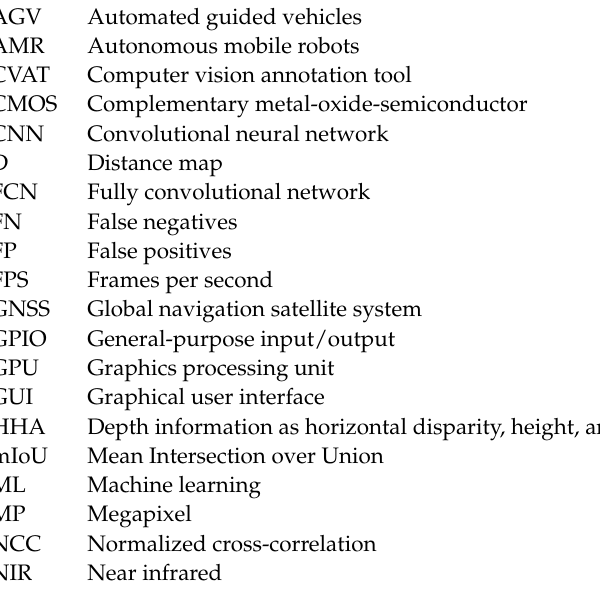
setups and for working distances between 0.5 and 1m; Table S3: Confusion matrix for ESANet trained on RGB-D with input resolution of 1280 × 960 pixels after 1357/1500 epochs; Table S4: Confusion matrix for ESANet trained on RGB-D with input resolution of 1024 × 512 pixels after 1307/1500 epochs; Table S5: Confusion matrix for ESANet trained on RGB-D with input resolution of 640 × 480 pixels after 1415/1500 epochs; Table S6: Confusion matrix for ESANet trained on RGB with input resolution of 1280 × 960 pixels after 1330/1500 epochs; Table S7: Confusion matrix for ESANet trained on RGB with input resolution of 1024 × 512 pixels after 1352/1500 epochs; Table S8: Confusion Table S9: Confusion matrix for ESANet trained on D with input resolution of 1280 × 960 pixels after 1324/1500 epochs; Table S10: Confusion matrix for ESANet trained on D with input resolution of 1024 × 512 pixels after 1087/1500 epochs; Table S11: Confusion matrix for ESANet trained on D with input resolution of 640 × 480 pixels after 1051/1500